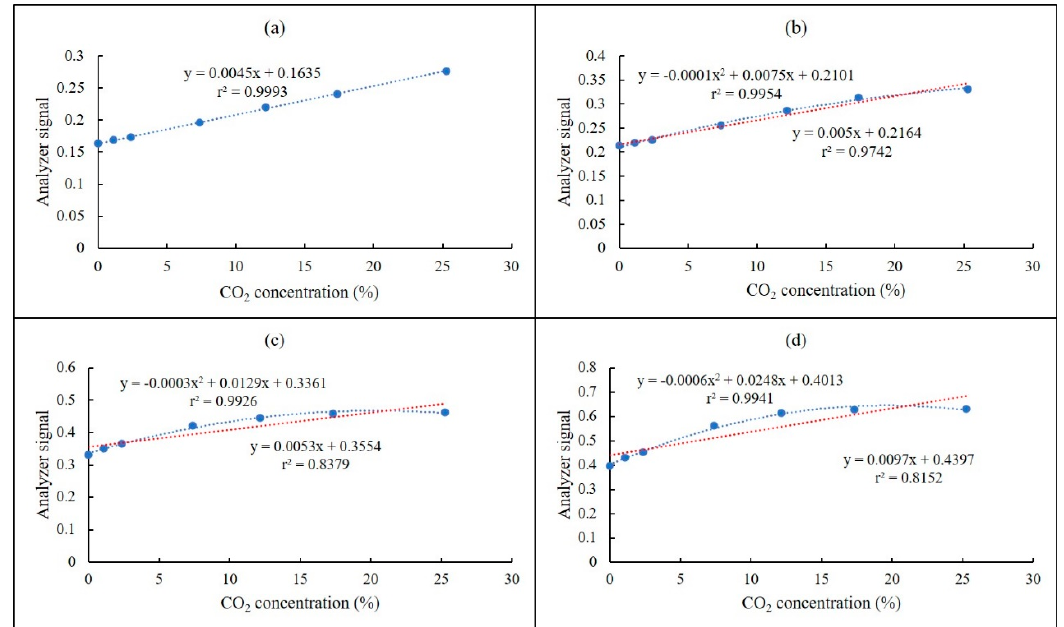
Figure 5. Variations of the analyzer signal associated with the pathlength and CO 2 concentration: ( a ) 4.8 m (1.5 × 10 − 5 < SD < 13.3 × 10 − 5 ), ( b ) 8 m (2.5 × 10 − 5 < SD < 67.2 × 10 − 5 ), ( c ) 10.4 m (0.5 × 10 − 5 < SD < 62.1 × 10 − 5 ) and ( d ) 16 m (0.5 × 10 − 5 < SD < 35.2 × 10 − 5 ) .